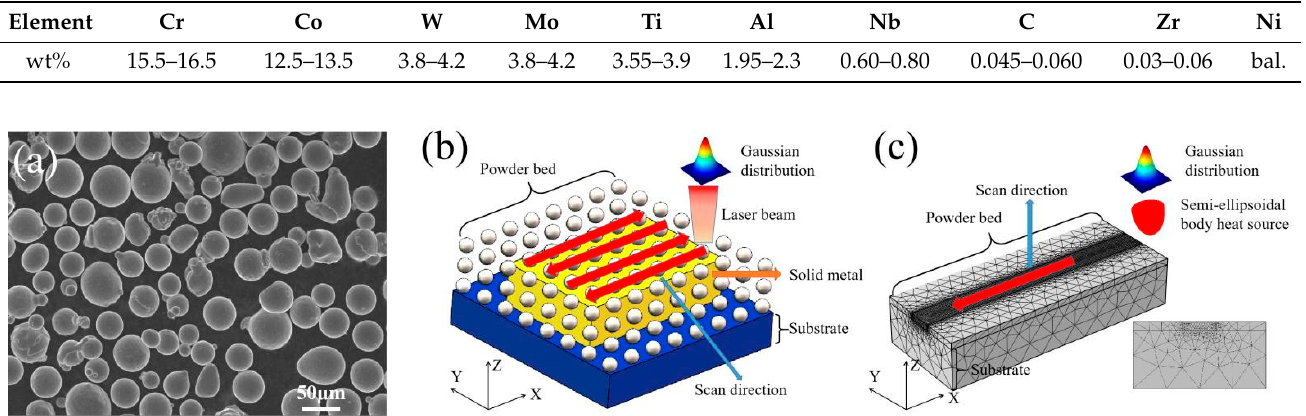
Table 1. Chemical composition of FGH96 superalloy powder.